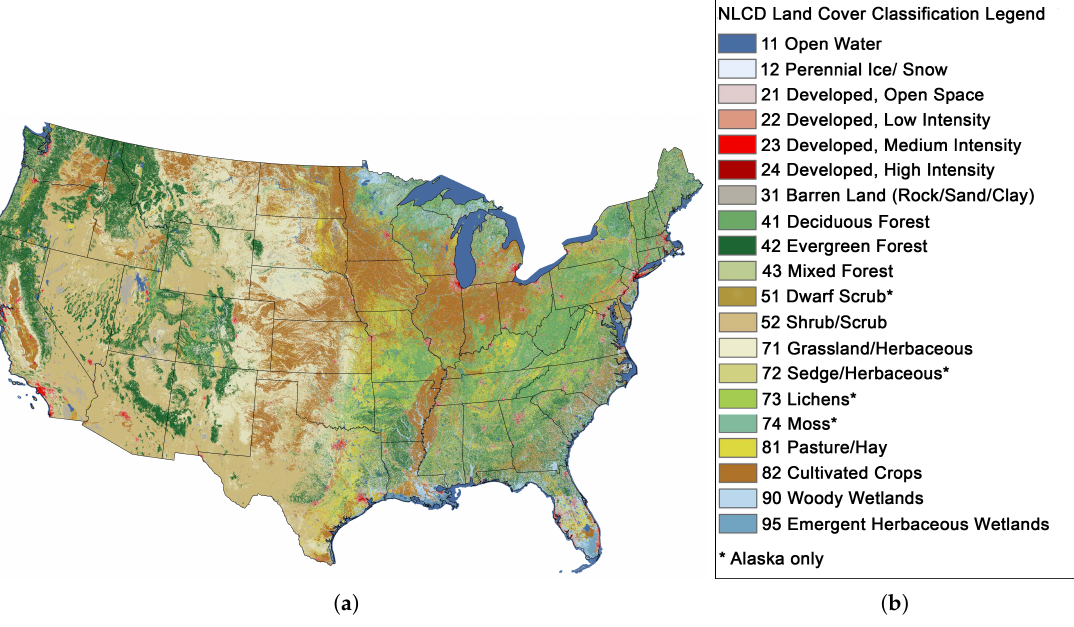
Figure 1. ( a ) The National Land Cover Database (NLCD) 2006 map [33]; ( b ) The legend to NLCD 2006 map [34].